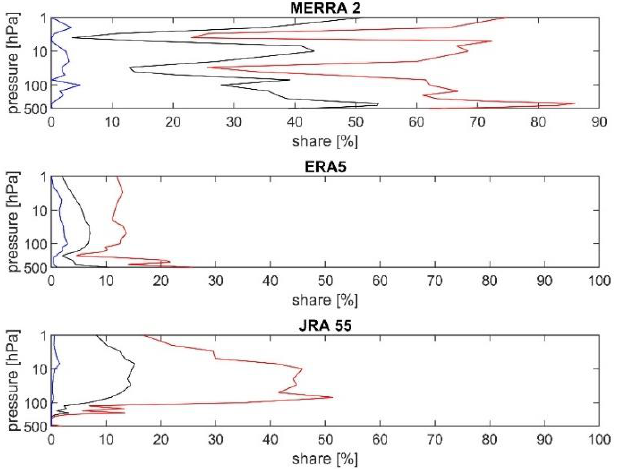
Figure 4. Vertical profile of average (black), minimal (blue) and maximal (red) share of explained discontinuities by the year 2004 to all grids from all months from the Pettitt test for MERRA-2 ( upper panel ), ERA-5 ( middle panel ) and JRA-55 ( lower panel